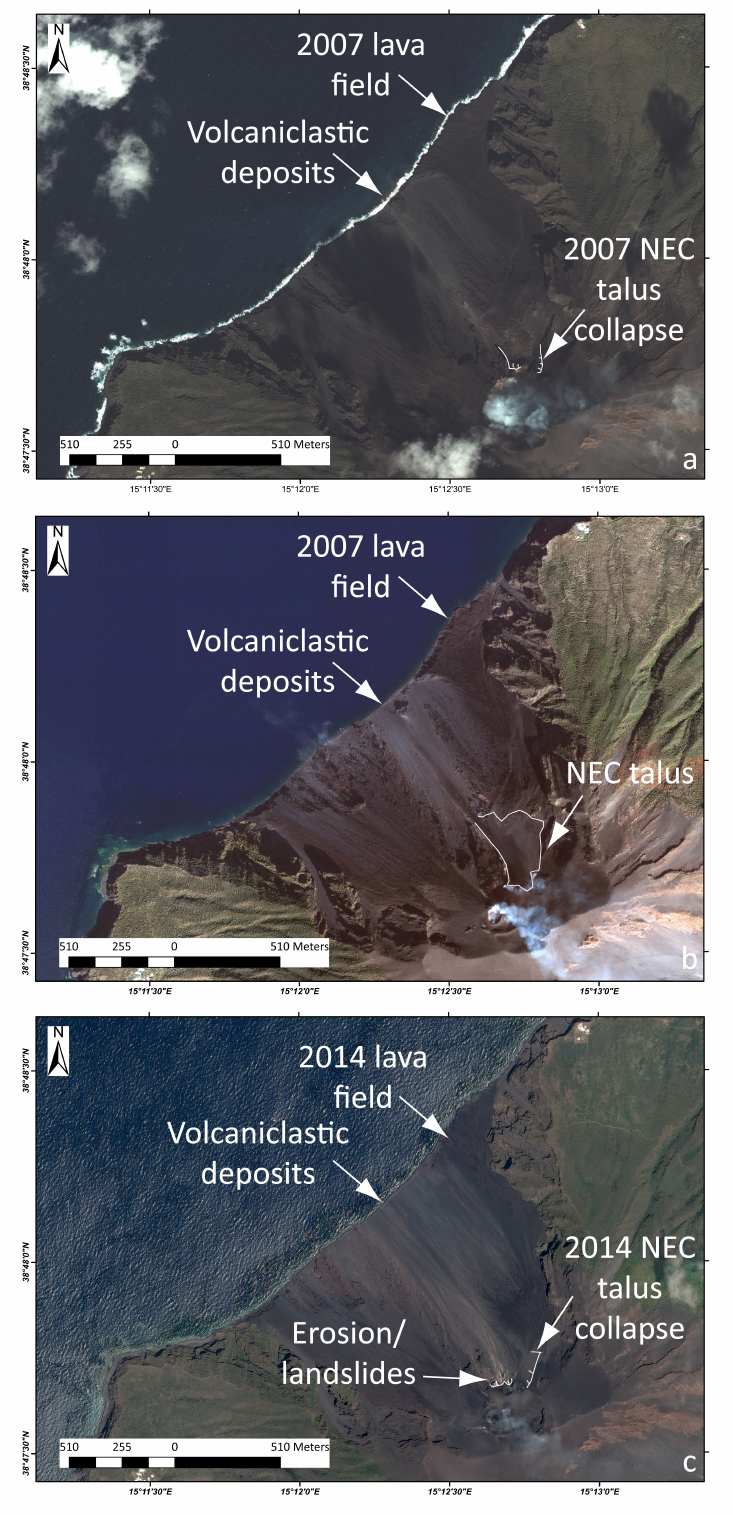
Figure 2. HSR optical images of the Sciara del Fuoco (SdF) and crater terrace. QUICKBIRD images collected on ( a ) 21 March 2008 and ( b ) 23 September 2012; ( c ) PL É IADES images collected on 13 June